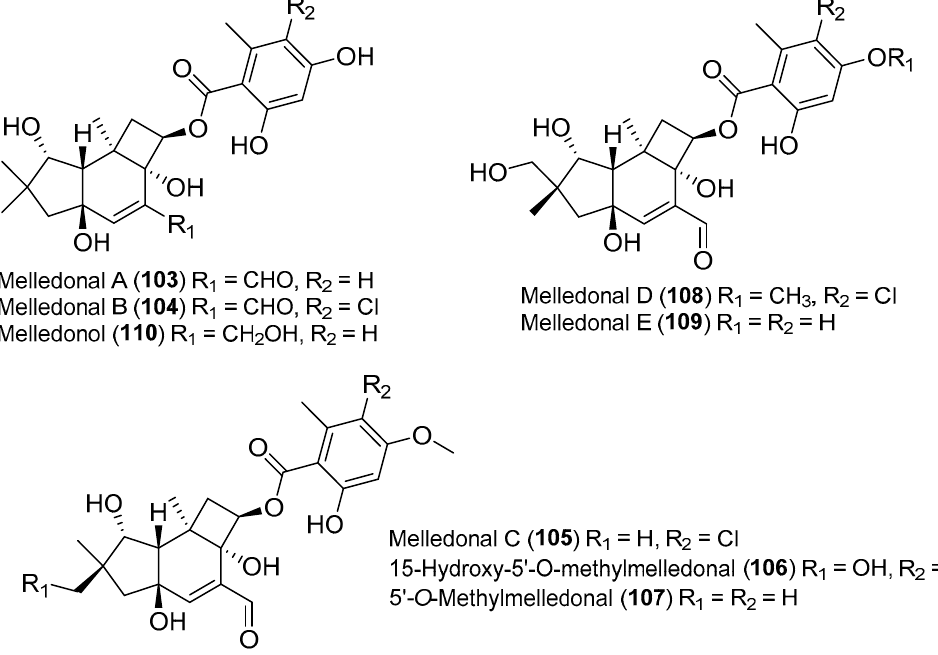
Figure 17. Structures of melledonals 103 – 109 and melledonol ( 110 ) isolated from the Armillaria and Clitocybe genera of fungi.